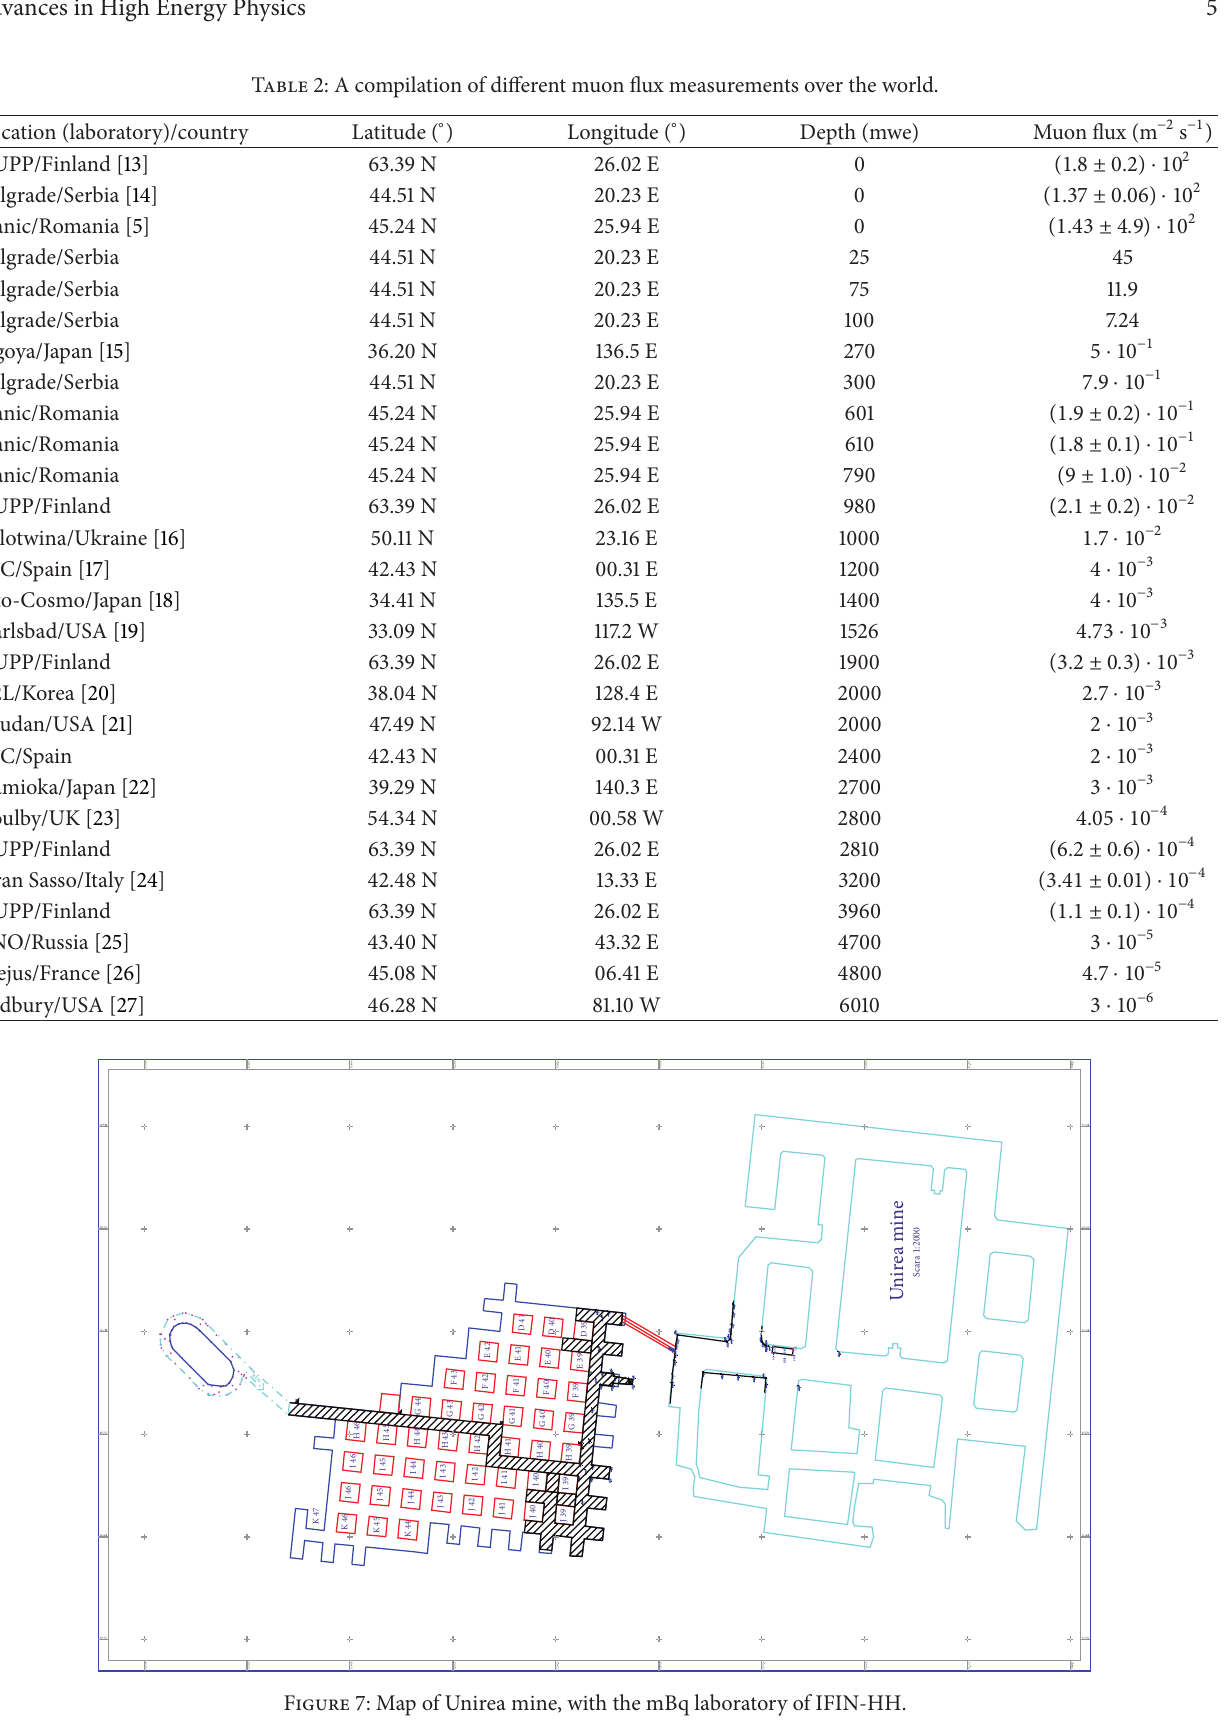
Figure 7: Map of Unirea mine, with the mBq laboratory of